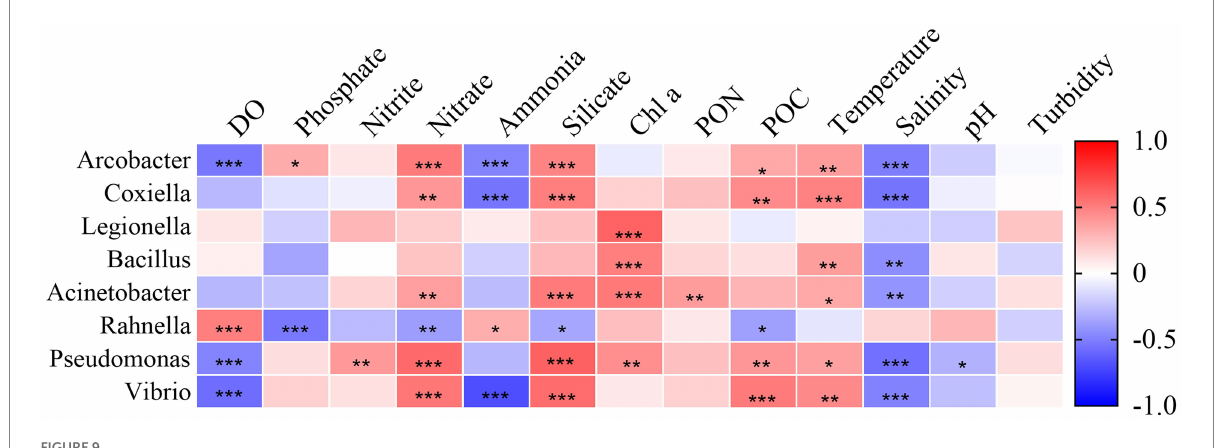
FIGURE 9 Environmental factors associated with changes in the community structure of pathogenic bacteria at the genus